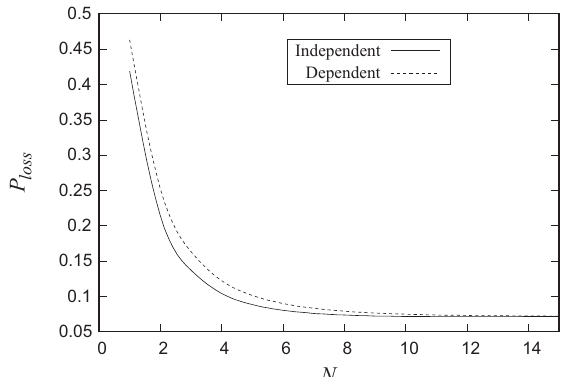
Figure 4. Dependence of the probability P loss on the number N .